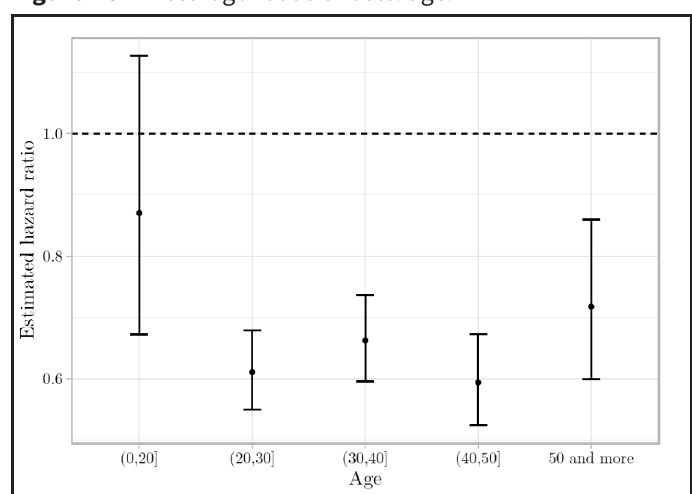
Figure A5 Heterogeneous effects: age.